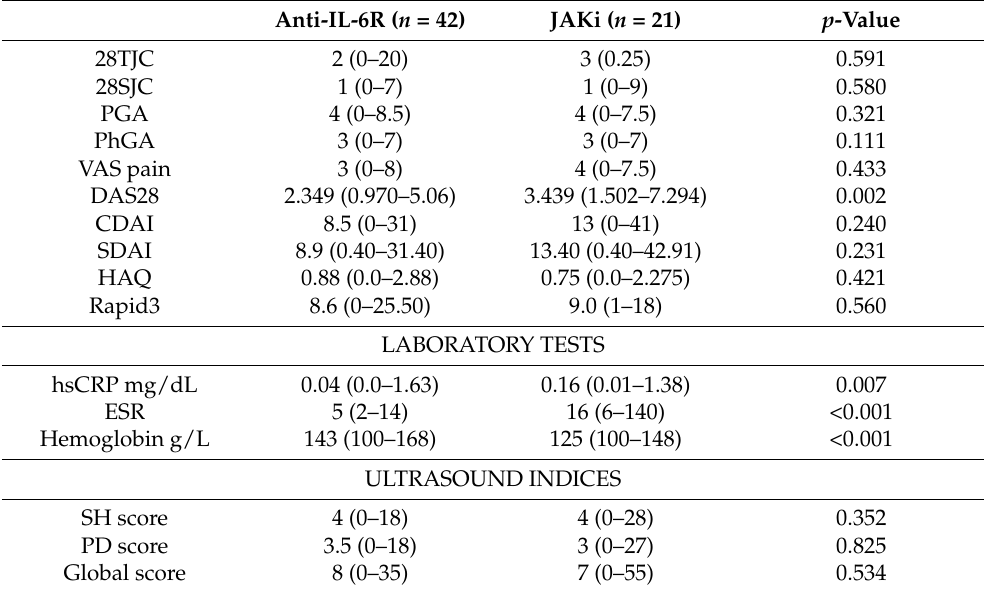
Table 2. Clinical disease activity, patient reported outcomes, and ultrasound synovitis scores by therapeutic